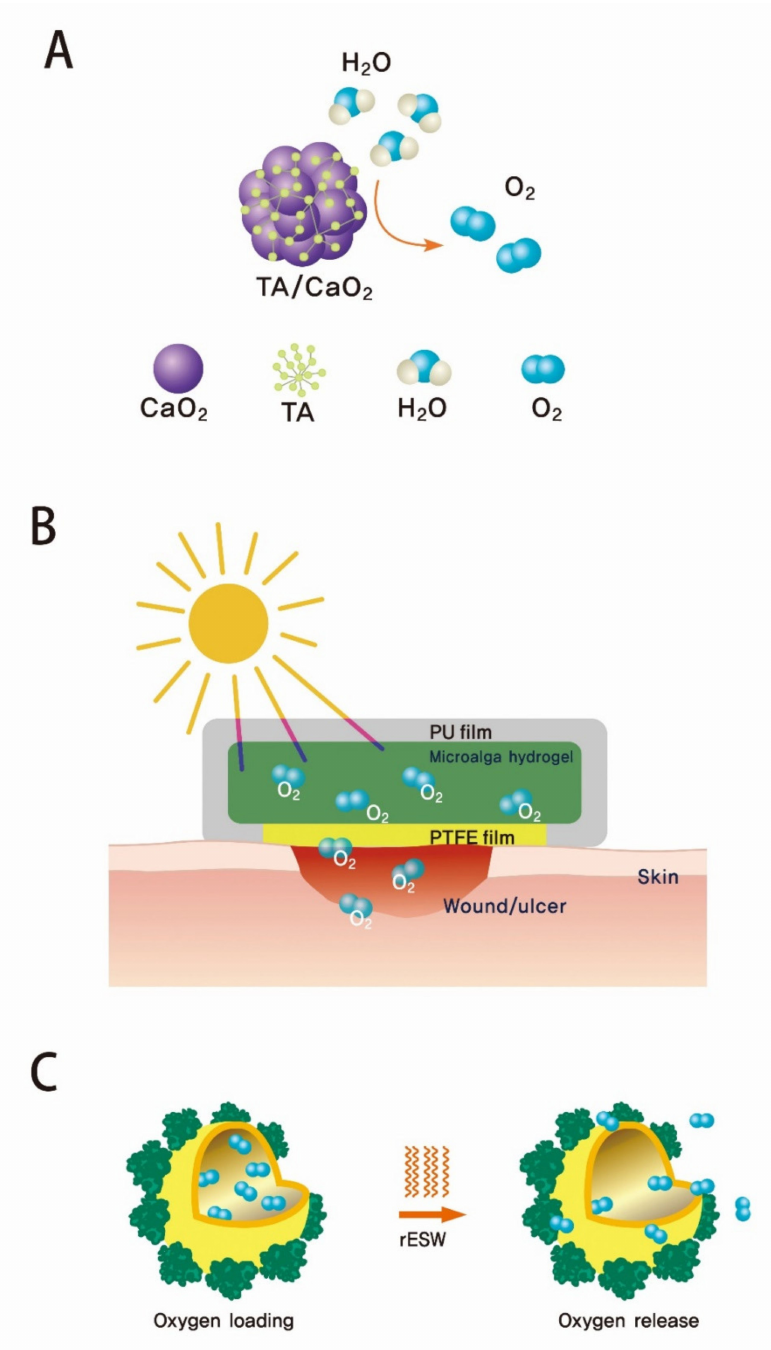
Figure 4. Recent development of oxygen-releasing composites applicable for DFU